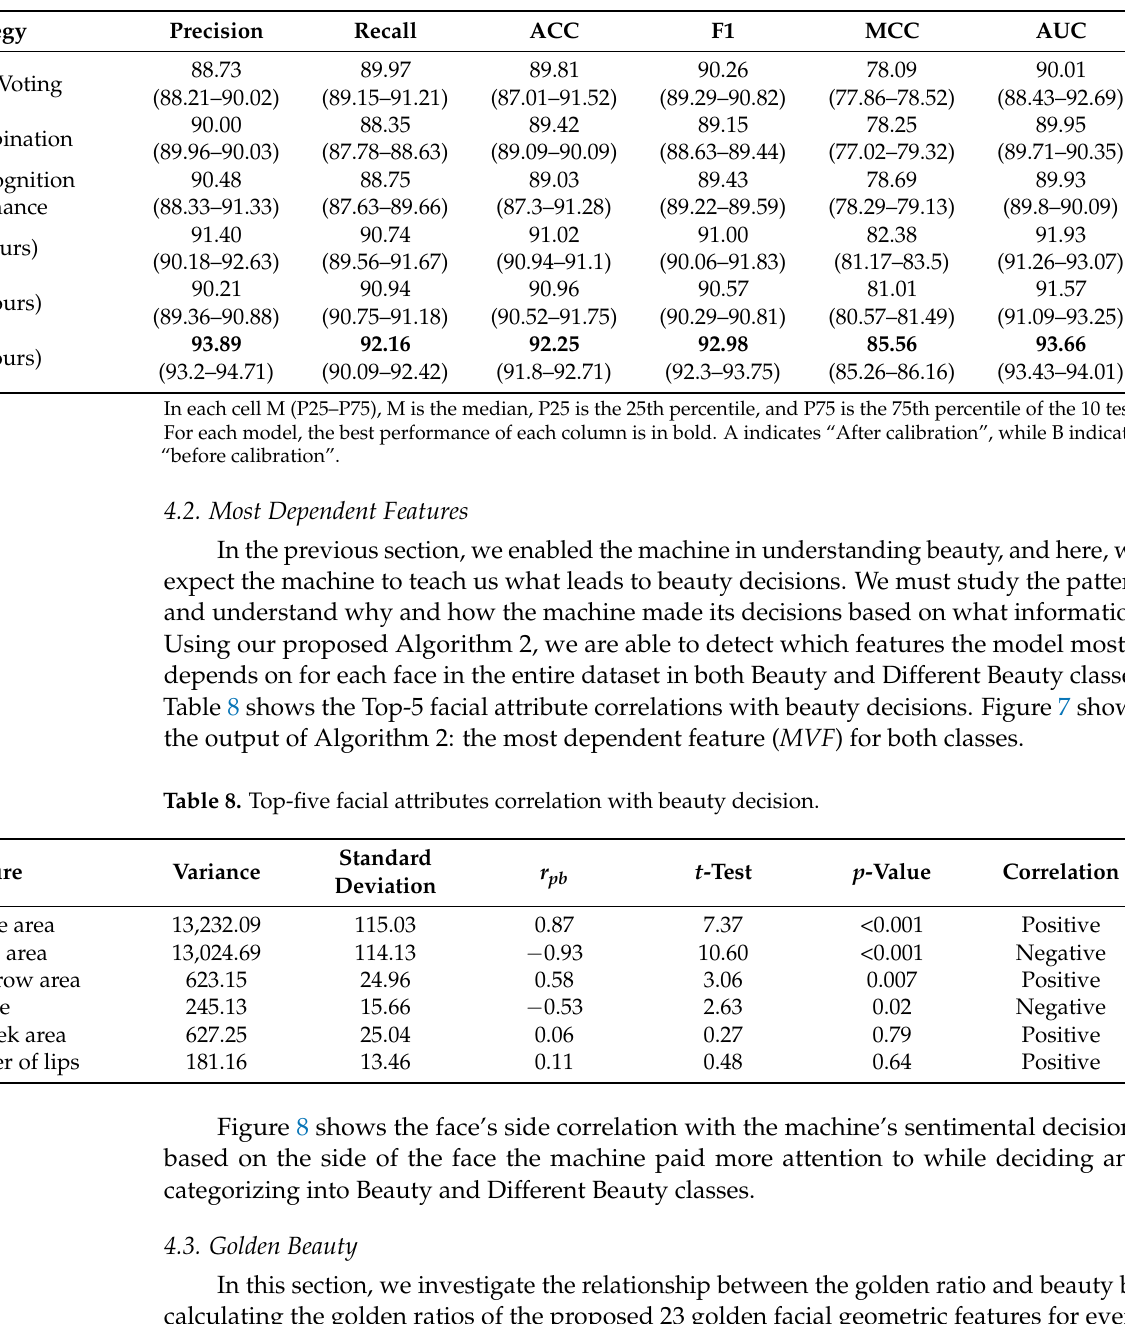
Table 7. Performance of the ensembled models on the test data.